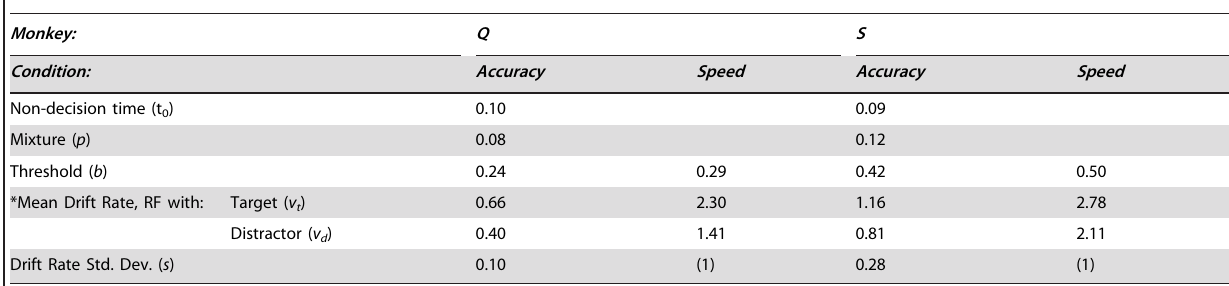
Table 1. LBA parameter estimates.